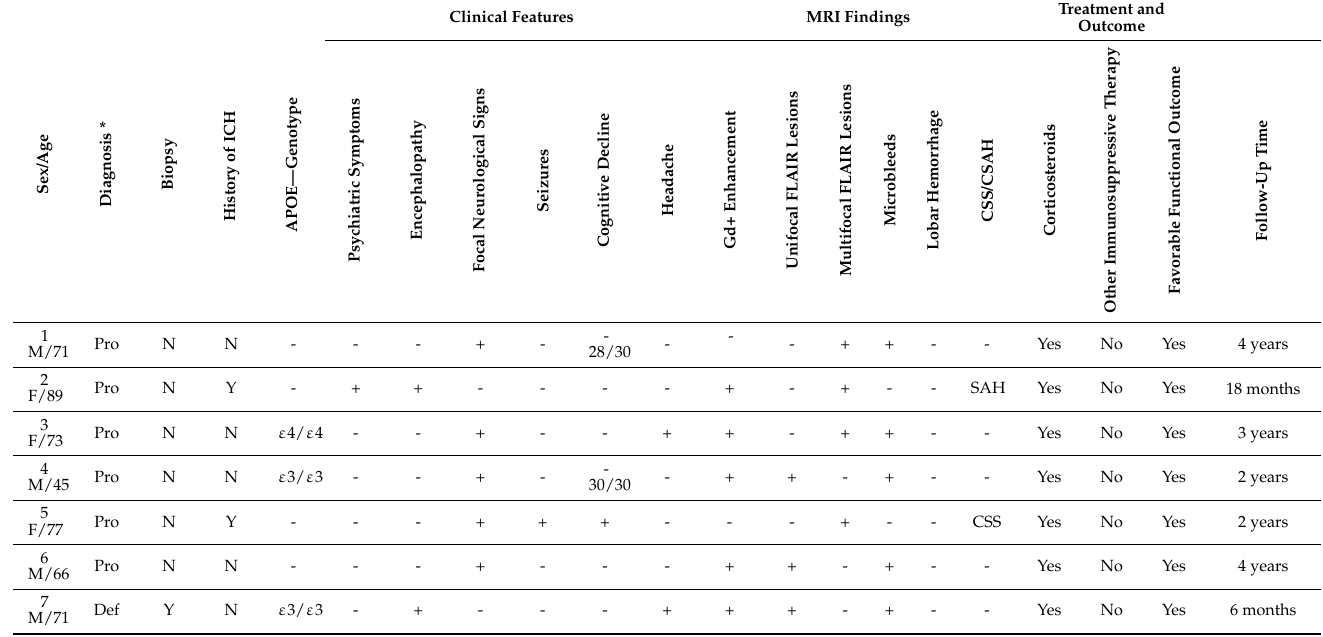
Table 1. Summary of the characteristics of patients diagnosed with Cerebral amyloid angiopathy- related inflammation at our